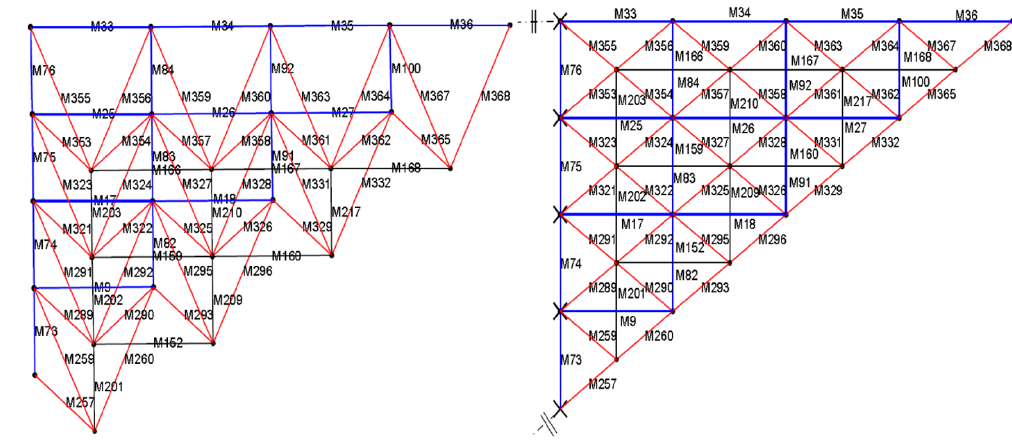
Fig. 8. The 1/8 structure system